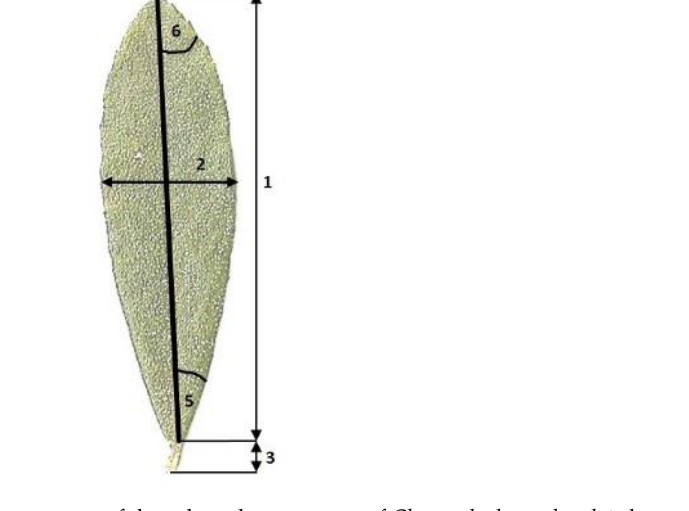
Figure 5. The technique of measurements of the selected parameters of Chamaedaphne calyculata leaves at the new site near Nerwik village (based on [7,8]).